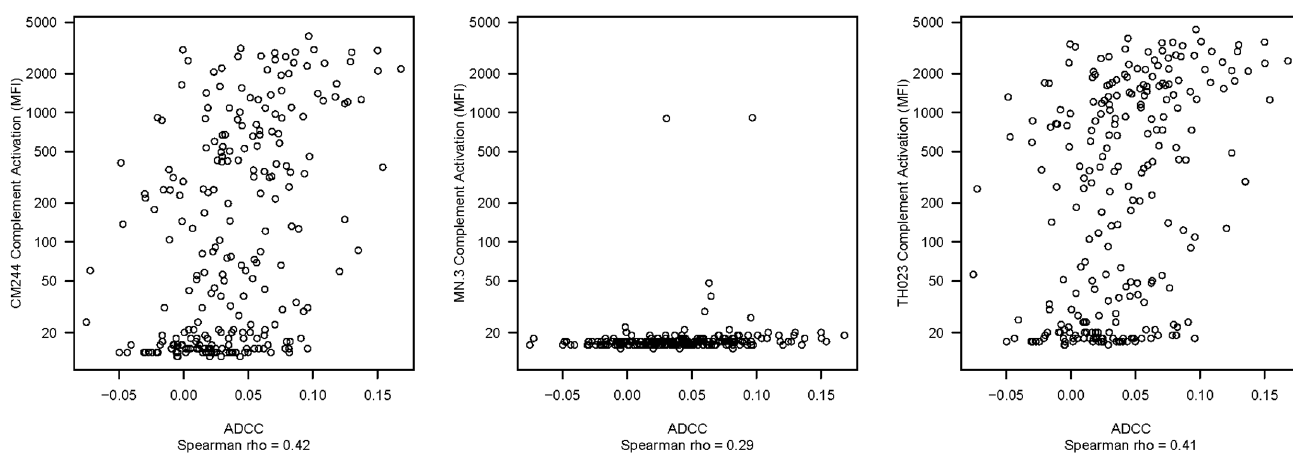
Fig 6. Association of complement activation with the primary ADCC variable in RV144. Shown are associations betweencomplementactivation and ADCC activity againstCM2544, MN.3 and TH023.